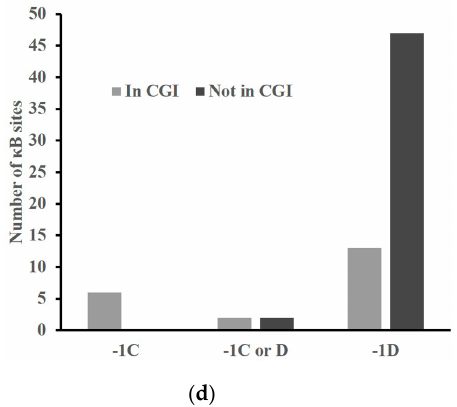
Figure 4. Hypo-methylation of the κ B site and its surrounding sequences is essential for the function of NF- κ B. ( a ) Expression of -1C κ B site containing genes (-1C genes) ( RelB and TNFAIP3 ) or -1D (D = A, T, G) genes ( CCL2 and I κ B α ) in U937 cells upon TNF α (10 ng/mL) stimulation. GAPDH expression was used as an internal control. Data shown are the results of one of three experiments; ( b ) -1C κ B sites used in this study. GSTP1 , glutathione S-transferase pi 1. The κ B site sequences were underlined. ( c ) Methylation status of κ B sites and their surrounding sequences of -1C genes (Figure 3a) analyzed by bisulfite sequencing PCR (BSP) in U937, 8226 and HEK 293T cells. The CpGs at -1 position of κ B sites are outlined. Methylated and non-methylated CpG sites were shown as solid or empty circles, respectively; ( d ) All -1C κ B sites are located in CGIs. The κ B sites in CGIs and their surrounding sequences ( − 500 to +500) of all 70 κ B sites shown in Figure 1 were analyzed using the MethPrimer program with the following parameters: Island size >100, GC Percent > 50.0, Obs/Exp > 0.6.